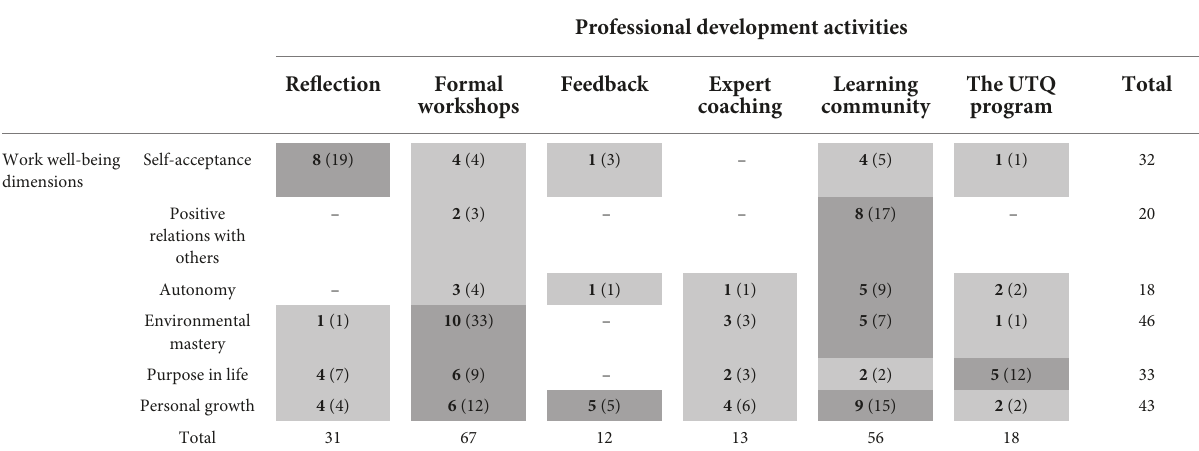
TABLE 3 Co-occurrence table of the professional development activities and psychological well-being dimensions.